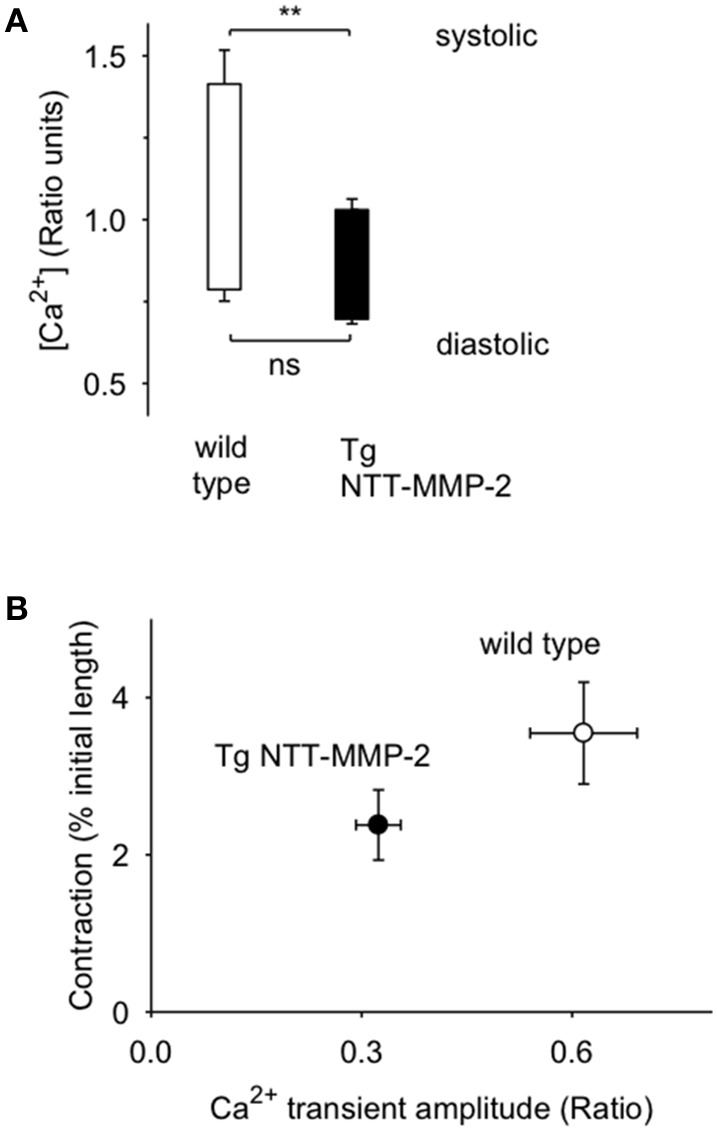
Pooled data from cells from Tg NTT-MMP-2 mice and wild type. (A) Cells from Tg NTT-MMP-2 hearts had lower systolic Ca2+ levels than cells from wild type (**P < 0.01). (B) Pooled data (mean ± SE) for contraction amplitude vs. Ca2+ transient amplitude for cells from Tg NTT-MMP-2 hearts and wild type [n = 16.22 cells/group from wild type mice (n = 5) and NTT-MMP-2 expressing mice (n = 4)]. Cells from Tg NTT-MMP-2 hearts had smaller Ca2+ transients and contractions compared to wild type. There was a significant linear relation between contraction vs. Ca2+ transient amplitude (P < 0.001).